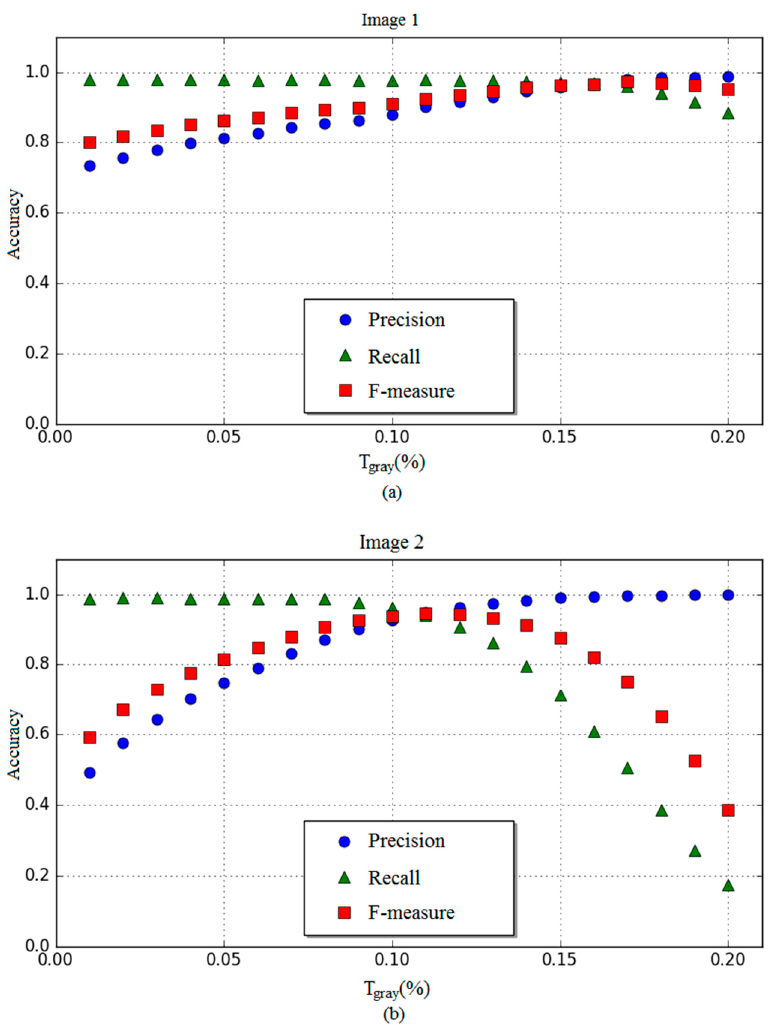
Figure 3. Accuracy of the tree detection results with the variation of parameter T gray . The precision, recall and F-measure for ( a ) Image 1; and Image 2 ( b ).